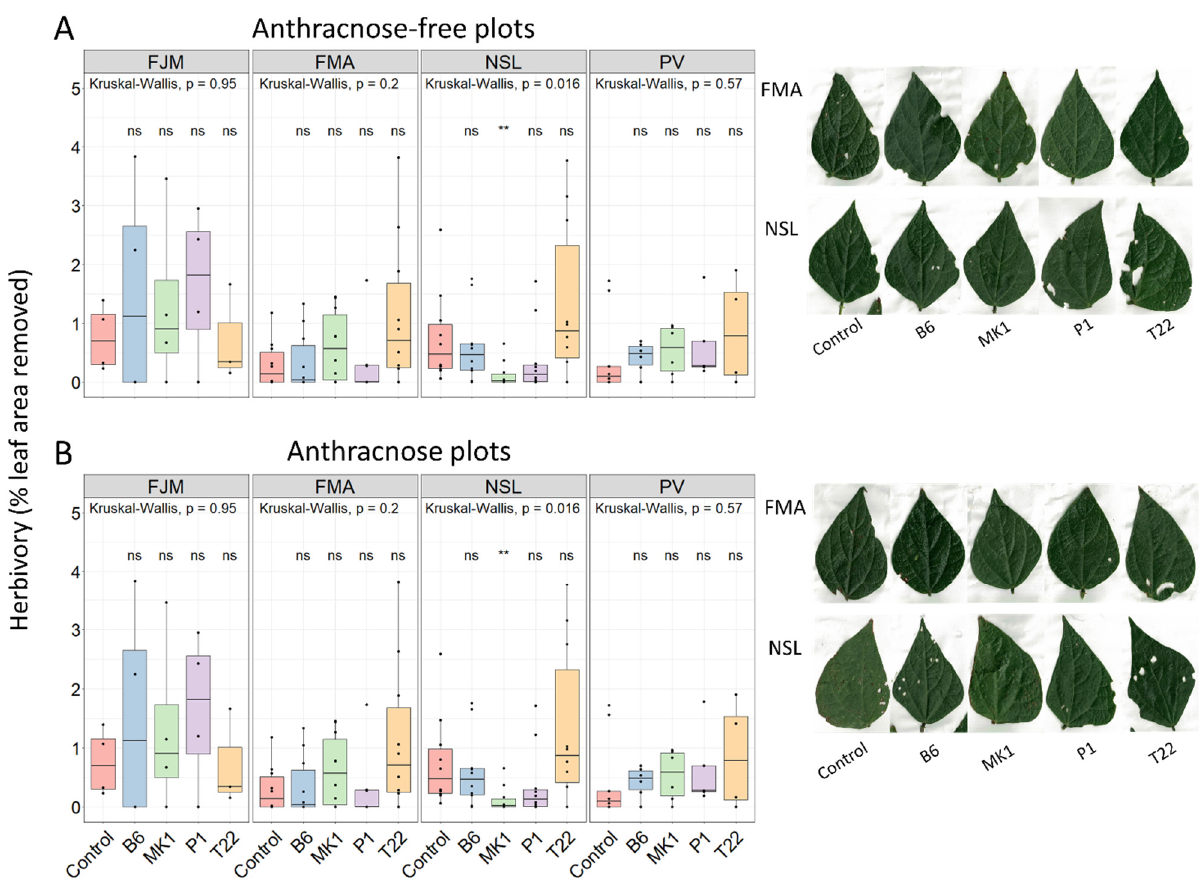
Figure 2. Herbivory levels of bean plants under open field conditions on ( A ) Anthracnose-free plots and ( B ) Anthracnose plots. Damage levels are expressed as percent missing leaf area and were quantified 20 d after leaf challenge with C. lindemuthianum . Common bean cultivars: FJM: Flor de Junio Marcela; FMA: Flor de Mayo Anita; NSL: Negro San Luis; PV: Pinto Villa. Trichoderma -treatments, Control: No Trichoderma ; B6: T. asperellum B6; MK1: T. longibrachiatum MK1; P1: T. atroviride P1; T22: T. harzianum T22. Boxplots indicate medians, 25th and 75th percentiles, whiskers extend to 1.5 times the interquartile range, data points beyond whiskers represent outliers. Asterisks indicate significant effects of Trichoderma inoculation on herbivory among plants of the same cultivar (** p ≤ 0.01, * p ≤ 0.05, ns: p > 0.05; based on Wilcoxon post hoc tests of n = max. 10 independent biological replicates (or less in cases of high soilborne mortality). Photos show representative herbivore-inflicted